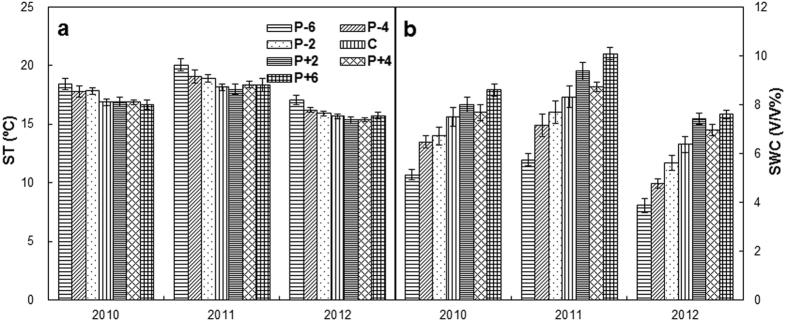
Annual variations (means ± SE) of soil temperature (ST, a) and soil moisture (SWC, b) at the depth of 10 cm in the three growing seasons, respectively.“P − 6”, “P − 4”, and “P − 2”: 60, 40, and 20% reductions in precipitation, respectively; “C”: ambient precipitation; “P + 2”, “P + 4”, and “P + 6”: 20, 40, and 60% increases in precipitation, respectively.